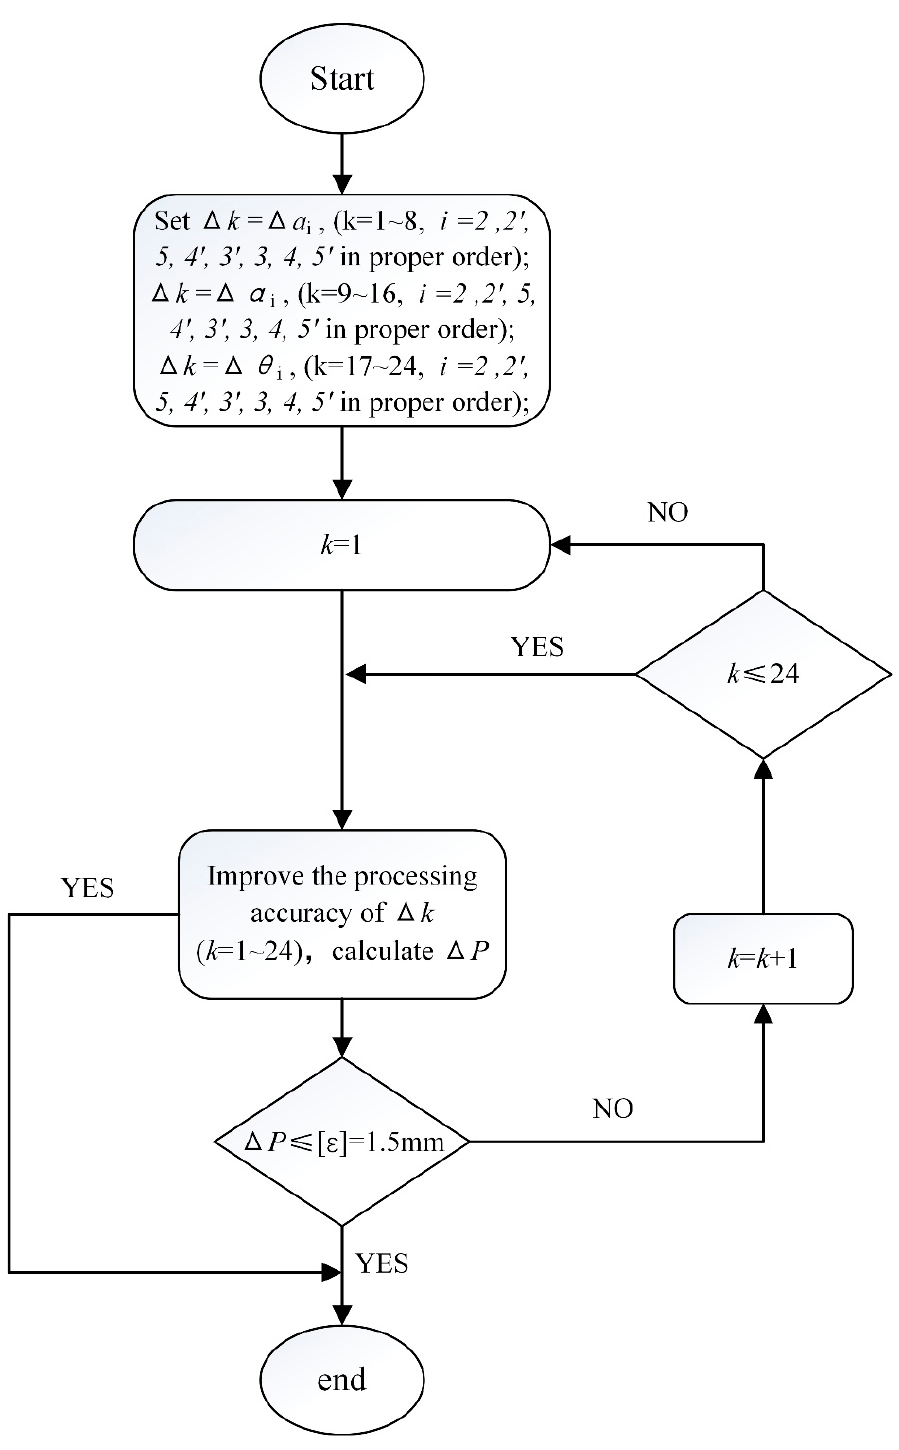
Figure 12. The process of tolerance assignment.